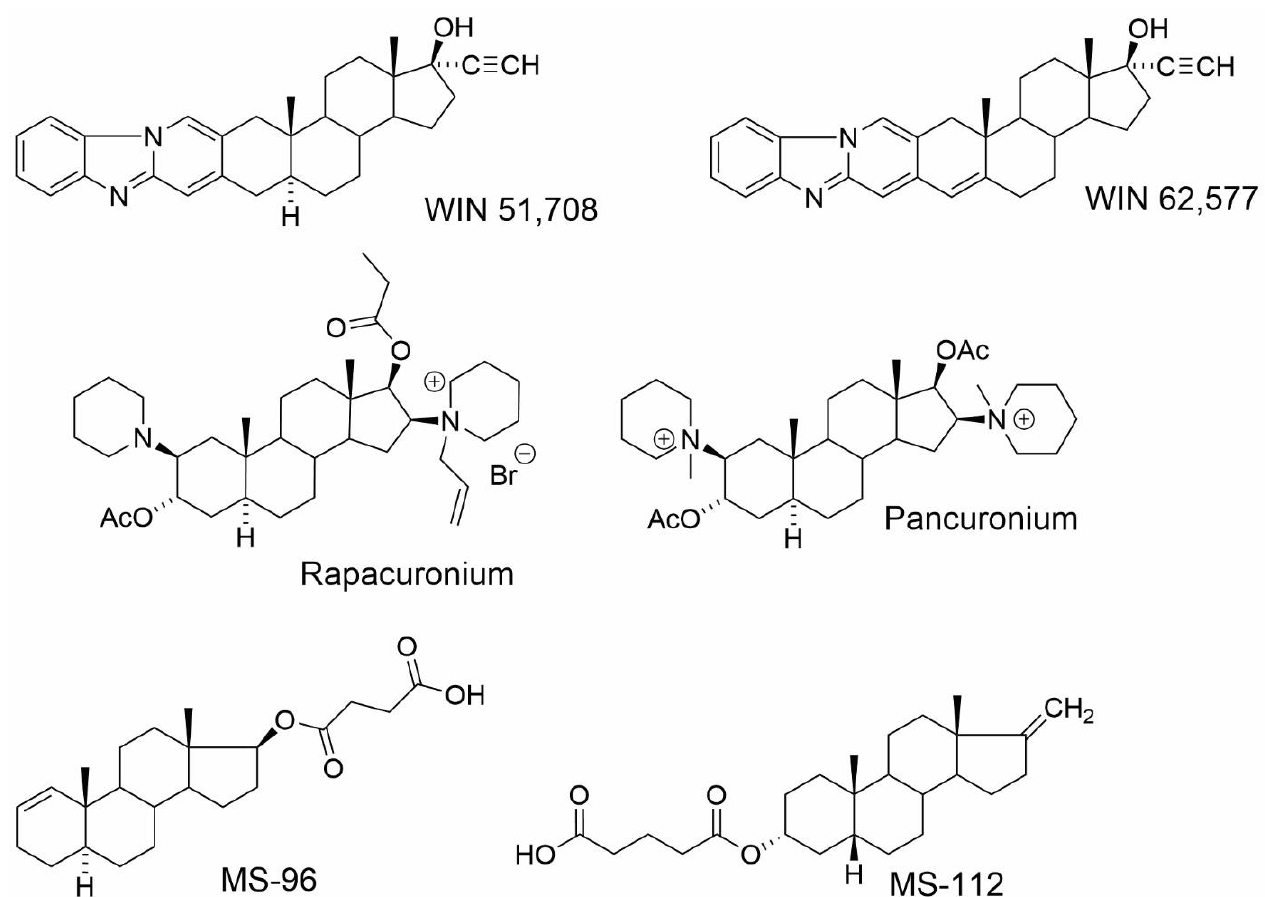
Figure 9. Structures of WIN compounds, the skeletal muscle relaxants pancuronium and rapacuronium and NASs tested in the study of Dolejsi et al. [47].